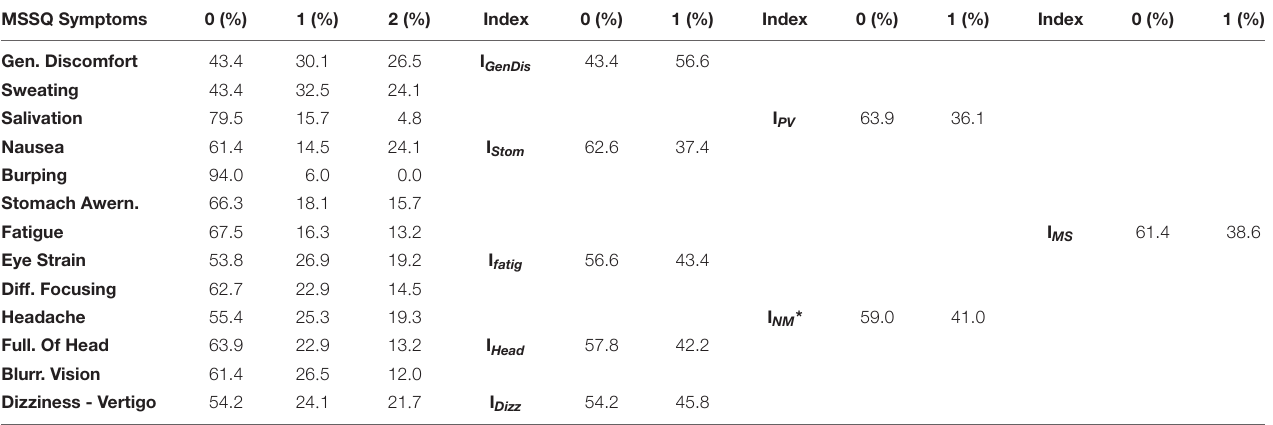
TABLE 3 | Percentage of the MSSQ answers for each symptom, and percentage of zeros and ones for the eight computed indexes. MSSQ